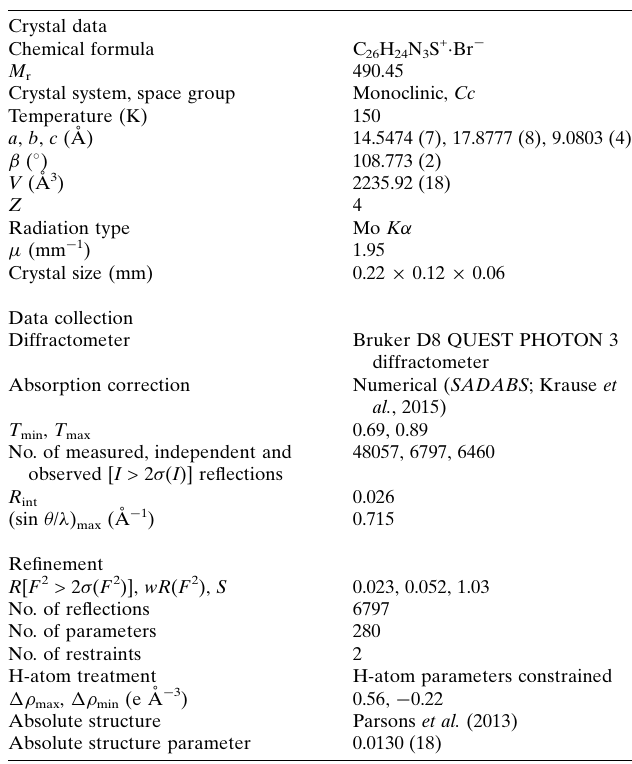
Table 2 Experimental details. Crystal data Chemical formula